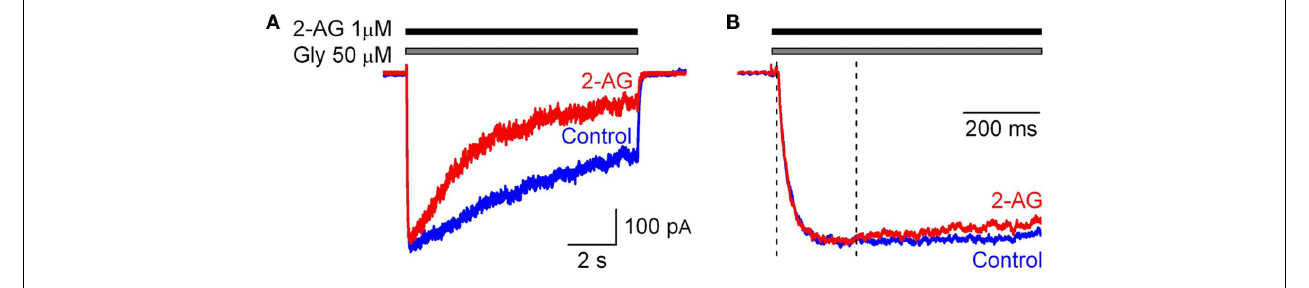
(B) Corresponding traces are normalized and superimposed. Note that changes in I GlyR kinetics can be detected from 200ms after the beginning of glycine and 2-AG co-application.